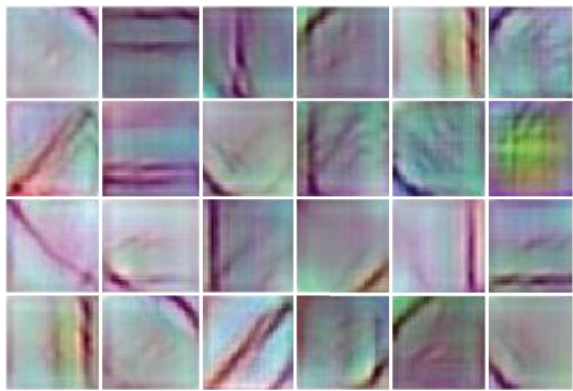
Figure 8: 24 randomly extracted features in the last convolution